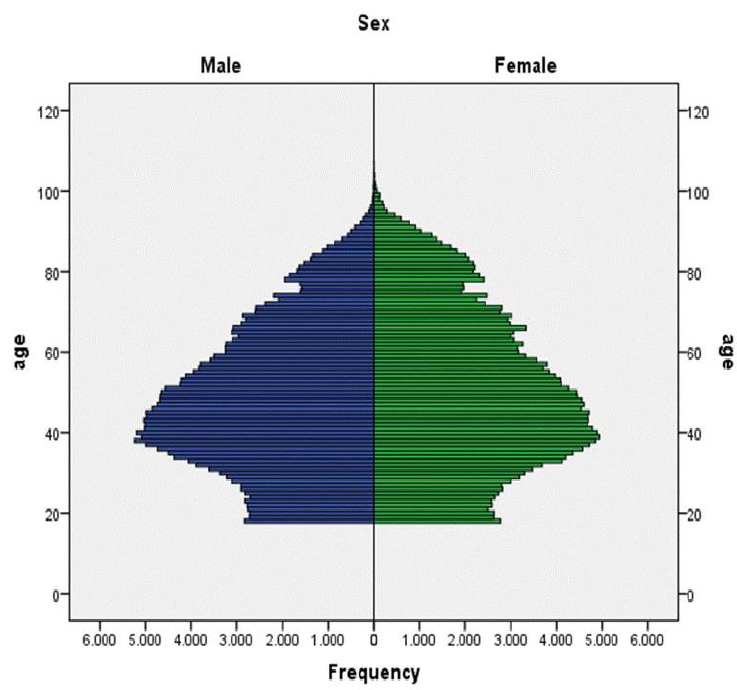
Figure 2. Age structure of the population. Table 1. Socio-demographic data of the population.